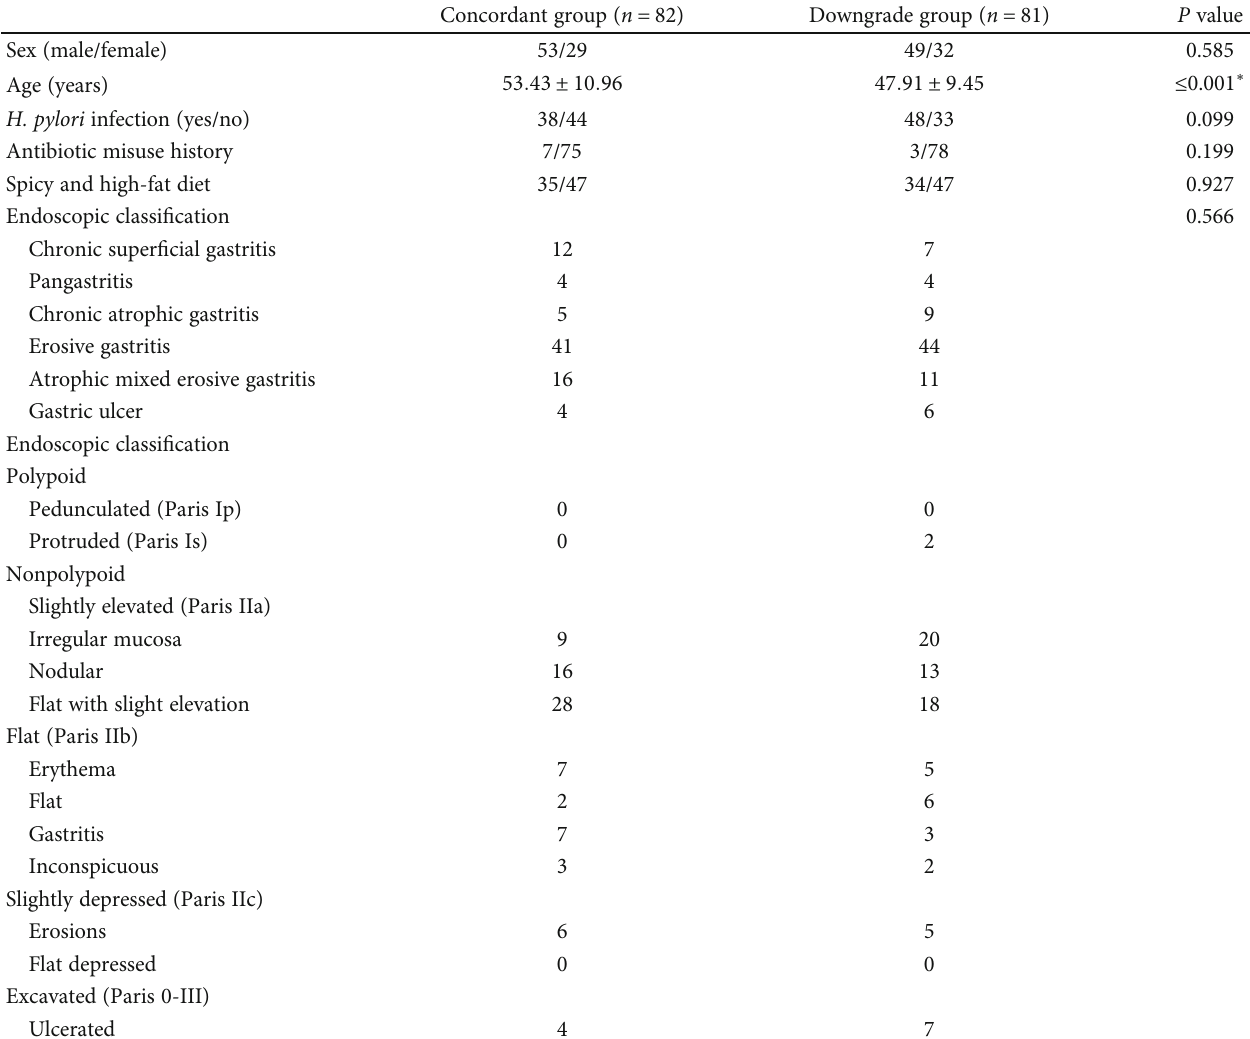
Table 7: The general and endoscopic characteristics of LGIN